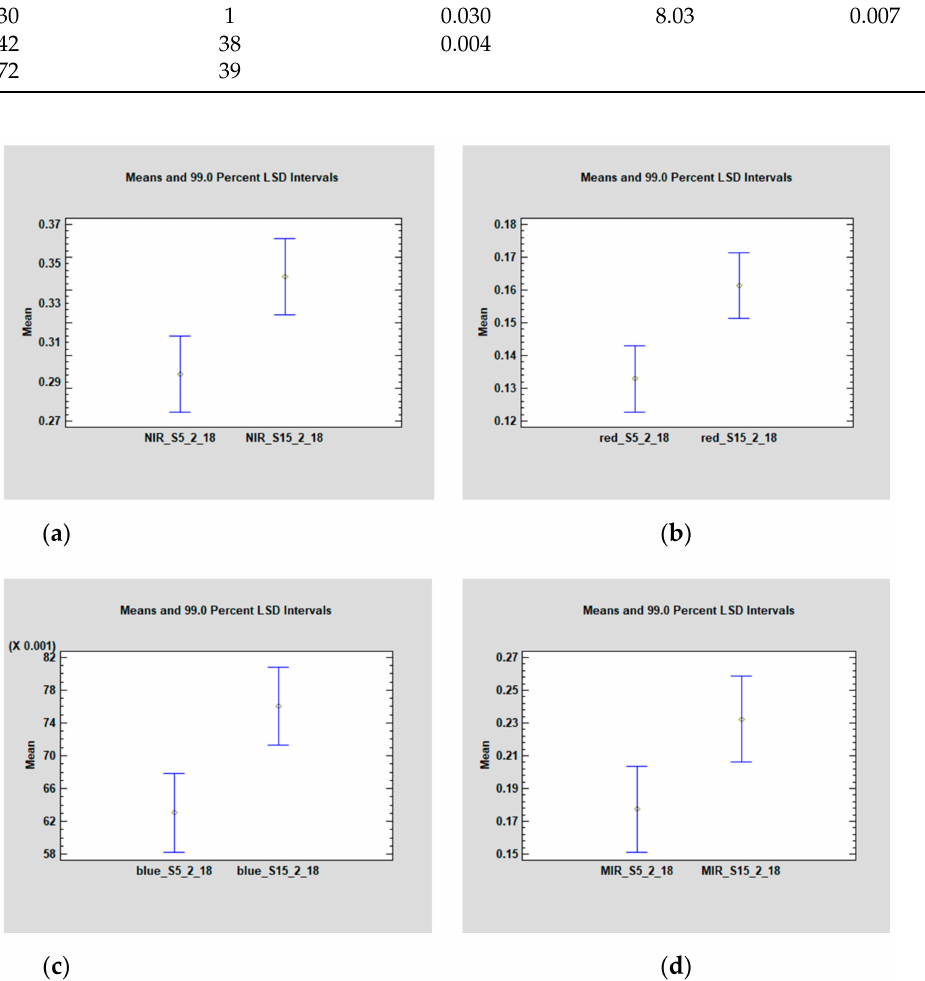
Figure 3. Intervals of confidence plots from the Least Significant Difference test (LSD) for SOM5 and SOM15 at DOY 49. ( a ) NIR, ( b ) Red, ( c ) Blue, ( d ) MIR mean band